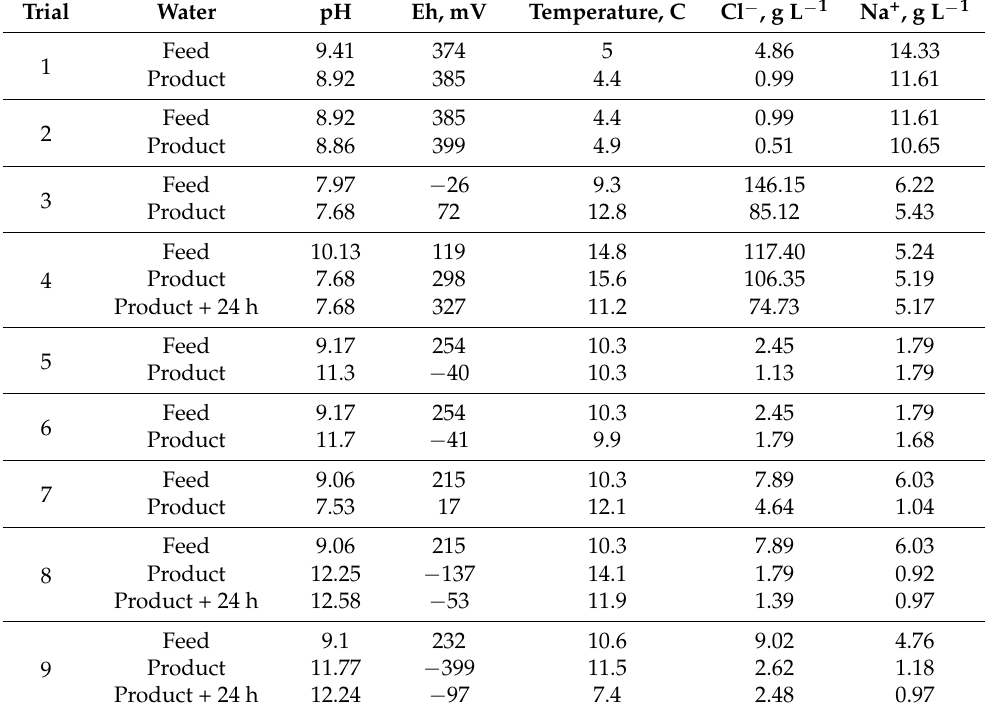
Table 2. Continuous flow trials decontaminating water containing Cl − ions and Na + ions. Reactor volume = 1.5 L; Flow rate: Trials 1, 3 = 0.25 L m − 1 ; Trial 4 = 0.2 L m − 1 ; Trial 5 to 9 = 0.4 L m − 1 ; Temperature = <20 ◦ C; Product analysis was made following the processing of the initial 45 L